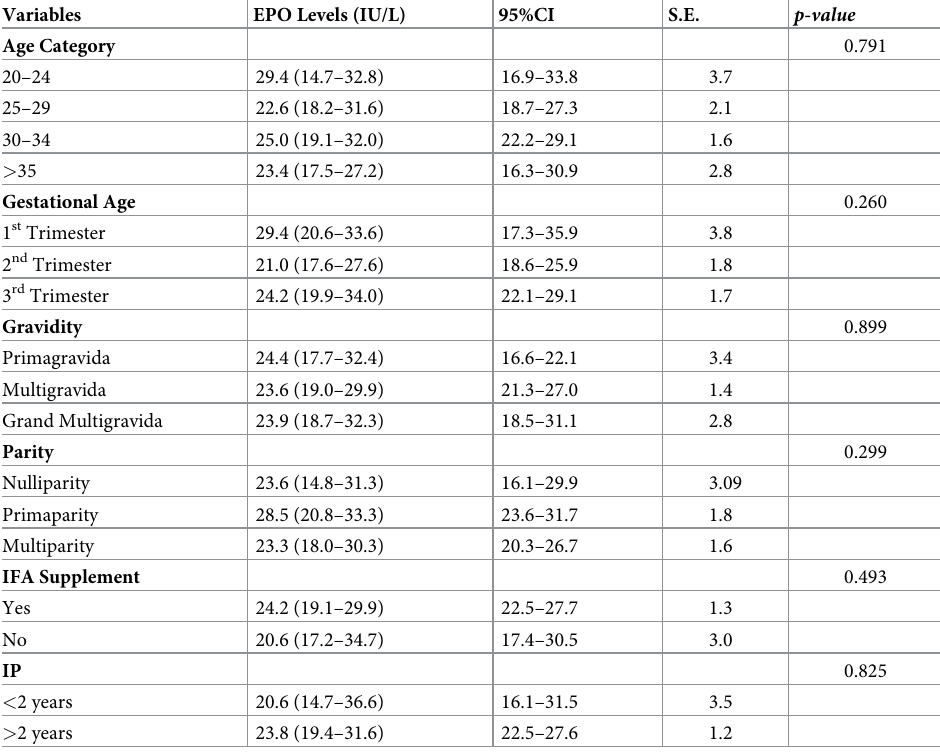
Table 5. Obstetric characteristics and serum erythropoietin levels among P . falciparum- infected pregnant women.